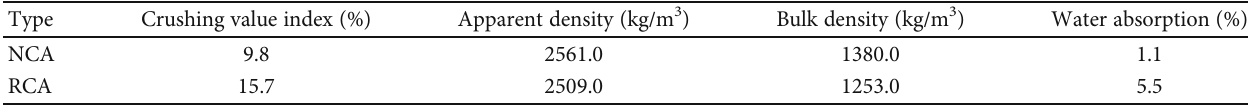
Figure 1: Coarse aggregate used in this study: NCA and RCA. Table 3: Properties of RCA and NCA.